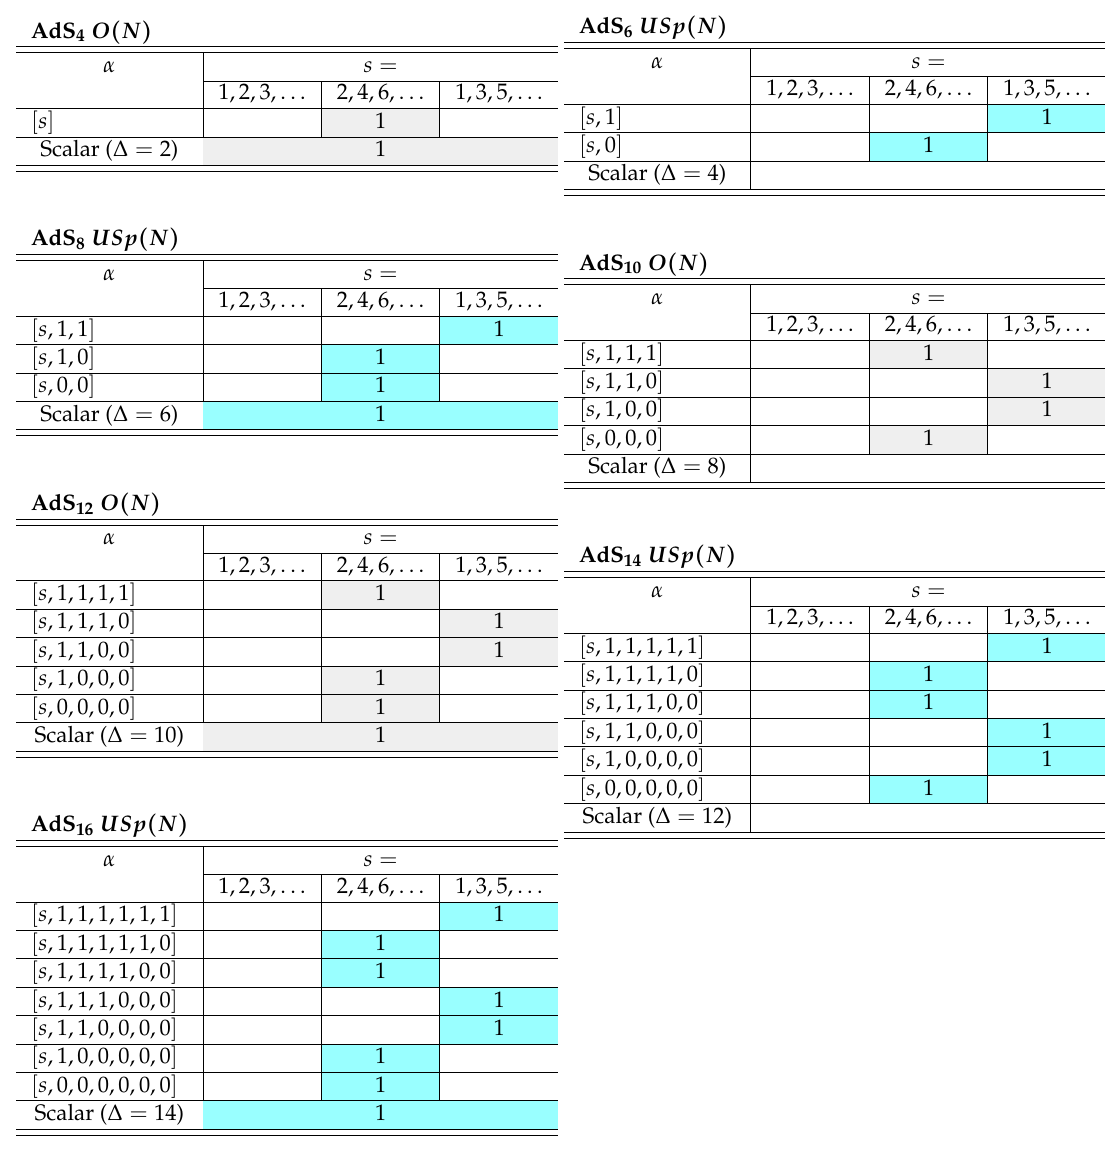
Table 5. Spectra of the minimal Type B theory dual to the fermionic vector model with Majorana (or symplectic Majorana) projection. The corresponding values of F ( 1 ) can be found in Table